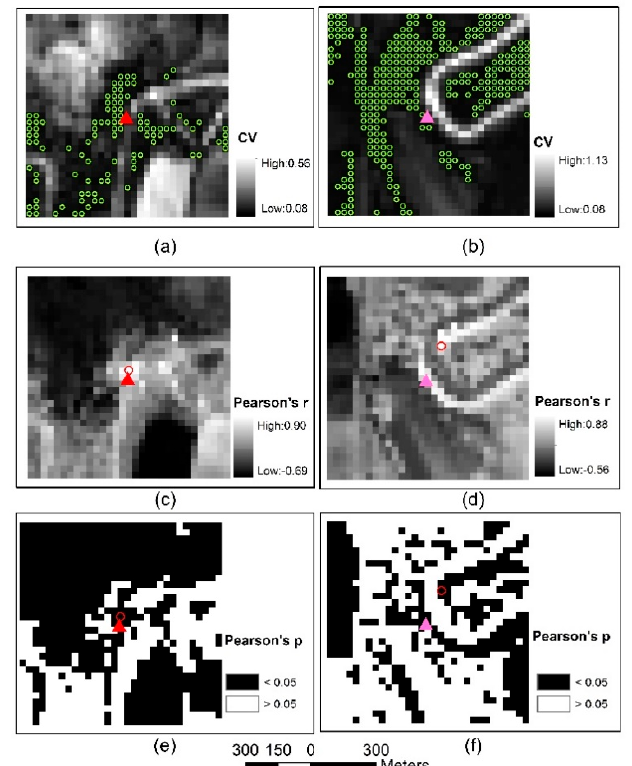
Figure 4. ( a ) Coefficient of Variation (CV) for region of interest (ROI) of Gauge 410130, ( b ) CV for ROI of Gauge 414200, ( c ) Pearson’s r for ROI of Gauge 410130, ( d ) Pearson’s r for ROI of Gauge 414200, ( e ) Pearson’s p -value for ROI of Gauge 410130, ( f ) Pearson’s p -value for ROI of Gauge 414200. Green circles on ( a ) and ( b ) stand for locations of multiple calibration ( c ) pixels obtained from CV. Final C value of one image is average value of these multiple C pixels. Red circles on ( c ), ( d ), ( e ), and ( f ) stand for the final locations of the single Measurement (M) pixel with the highest Pearson’s r . The triangles stand for locations of two gauges (red: 410130; pink: 414200).